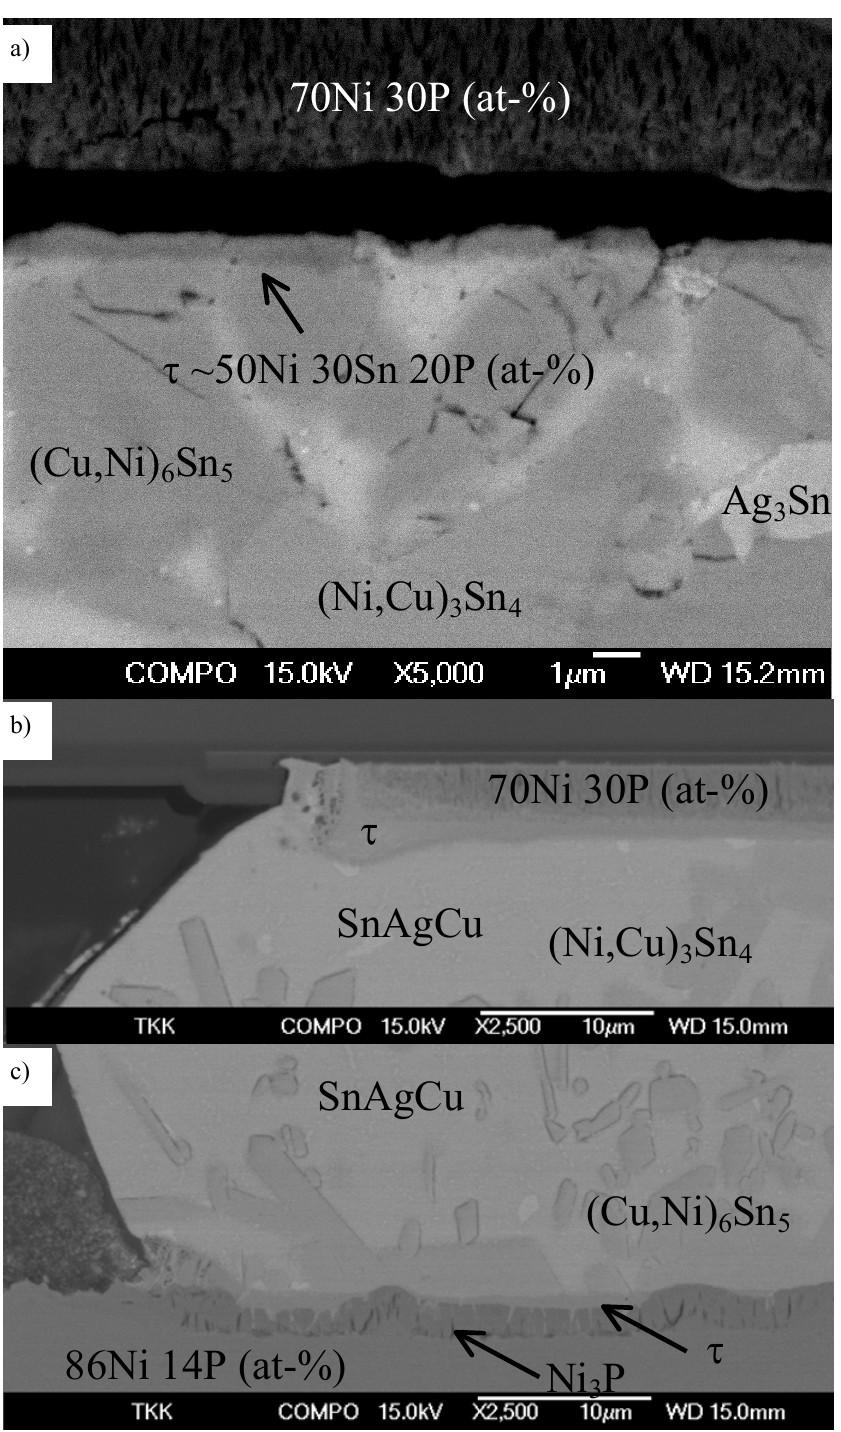
Figure 8. Backscattered SEM images (a) the component side, where the P concentration in Ni(P) is about 30 at-% annealed for 5 min at 250 °C, (b) the component side annealed for 20 min at 250 °C and, (c) the PWB side, where the P concentration in Ni(P) is about 14 at-%, annealed for 20 min at 250